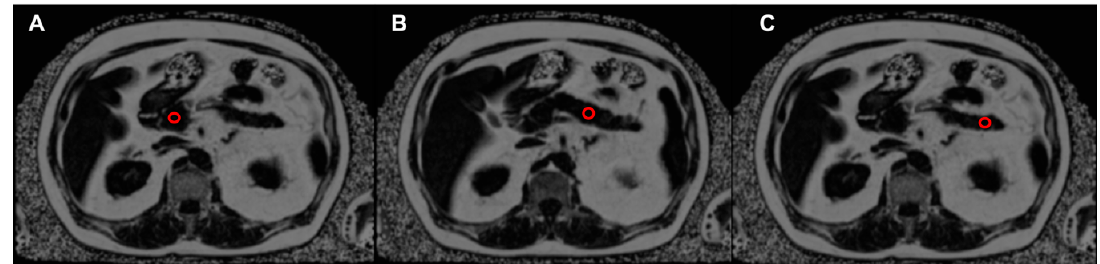
Figure 1. Assessment of pancreatic fat content on a proton density fat fraction (PDFF) map with the position of three regions of interest (ROIs, red circles). ( A ) Pancreatic head; ( B ) pancreatic body; ( C ) pancreatic